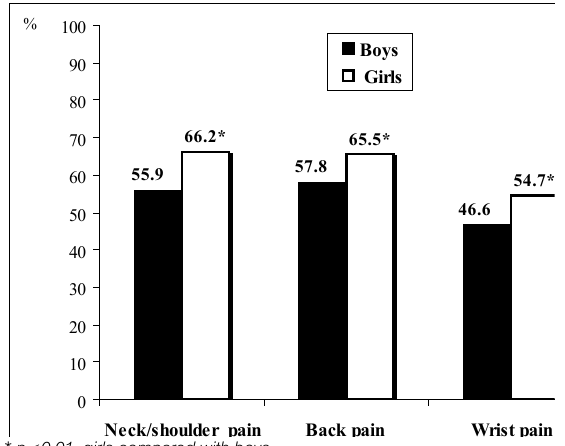
* p<0.01, girls compared with